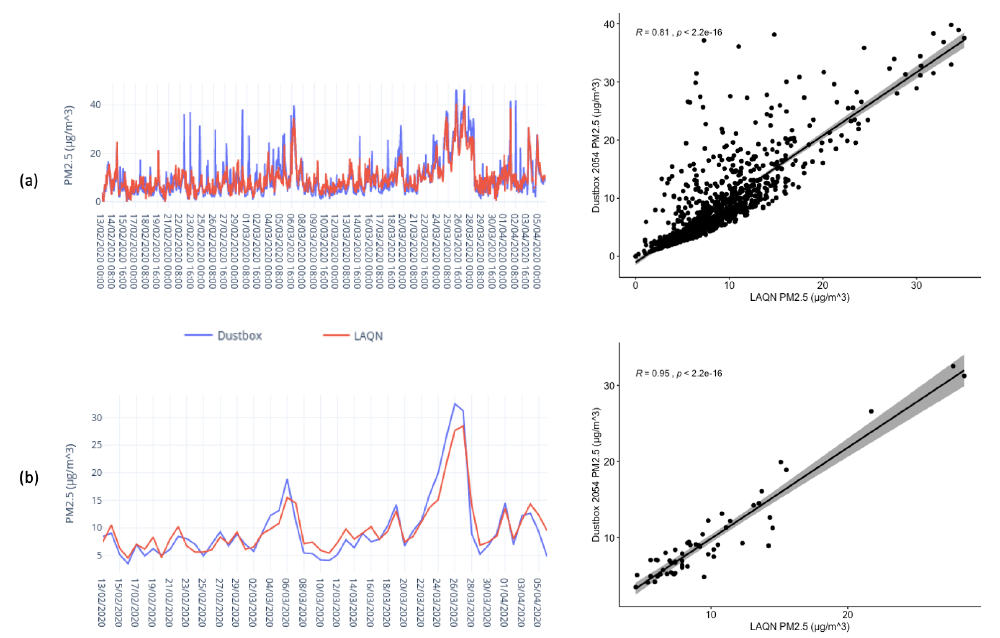
Figure 14. Line plots and scatter plots for Dustbox 2054 and LAQN NXG: ( a ) hly PM2.5 data; and ( b ) daily PM2.5